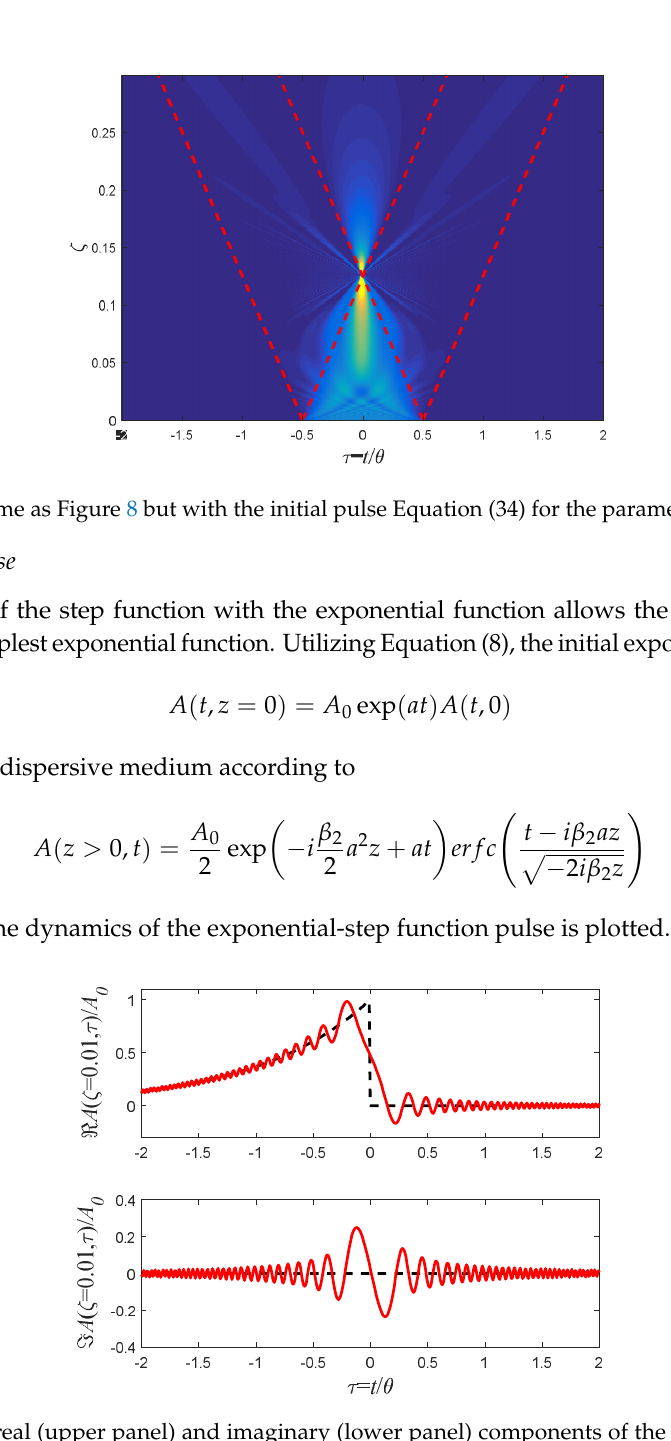
Figure 10. The real (upper panel) and imaginary (lower panel) components of the exponential-step function pulse (Equation (36)). The dashed curve represents the initial profile (for ζ = β 2 z / θ 2 = 0), while the solid curve represents its final shape (for ζ = β 2 z / θ 2 = ).